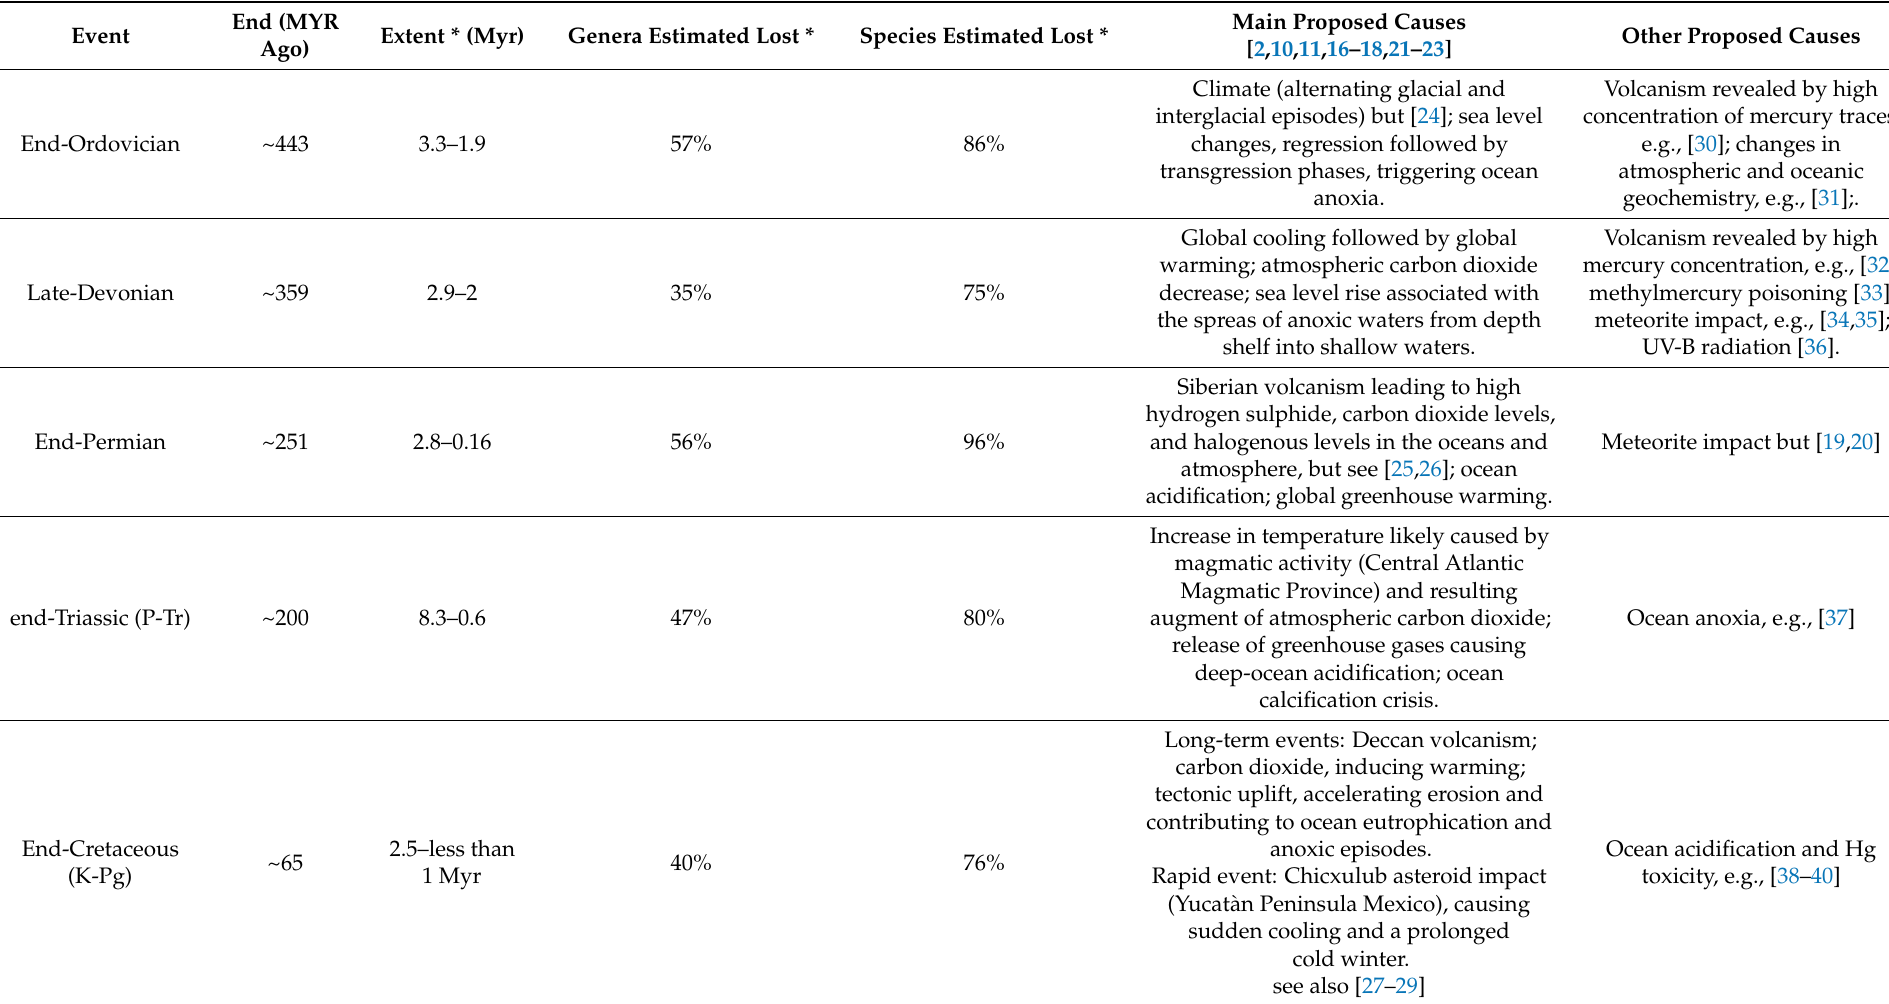
Table 1. Percentage of genera and species that went extinct during the “Big Five” pre-Quaternary mass extinction events (* = data from [2]), and some hypothesized causes, chosen among those that are either commonly acknowledged or